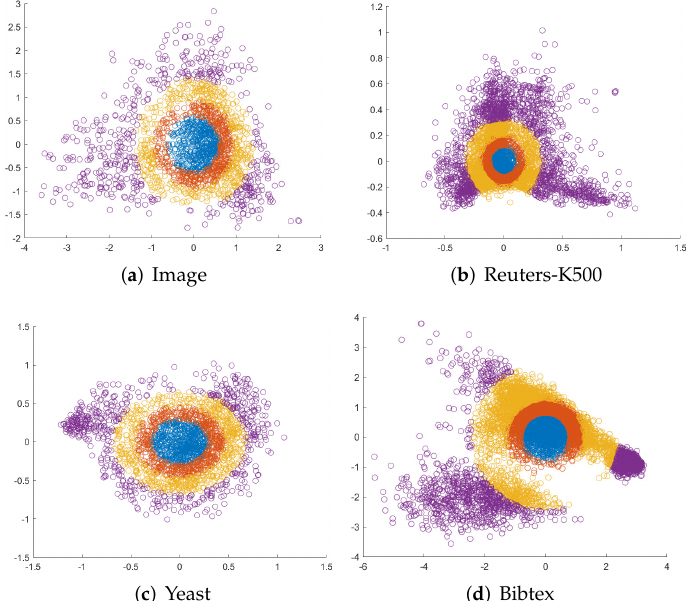
Figure 1. Illustrative examples of four multi-label data sets in a two-dimensional case. The annuluses are generated in the distribution trend of a multi-label data